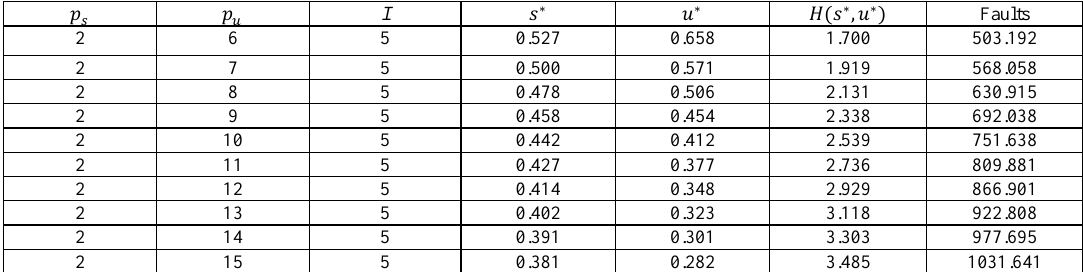
Table 6. The result of sensitivity